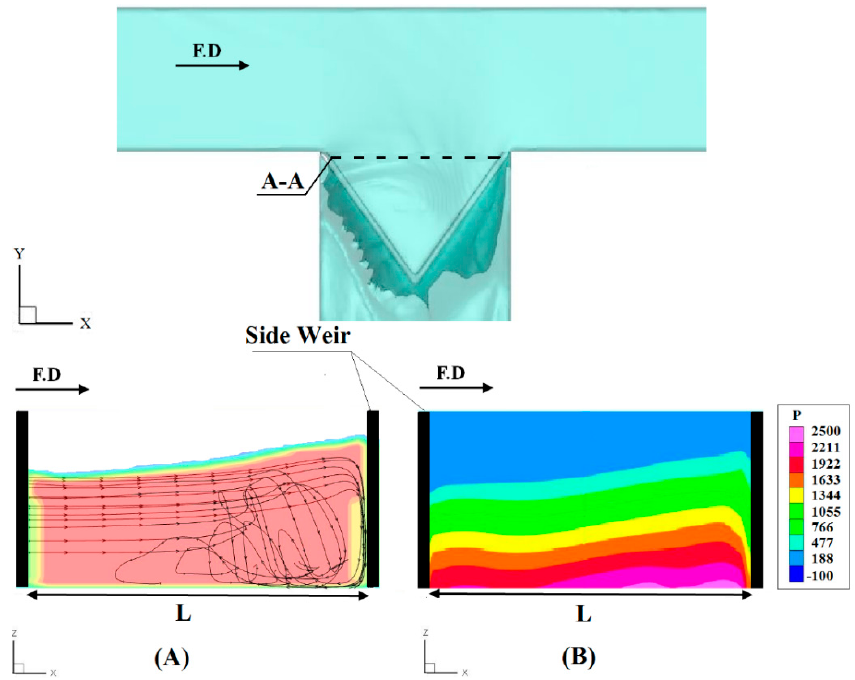
Figure 8. Lateral flow along the opening length of the triangular labyrinth side weir: ( A ) Streamlines; ( B ) pressure contour.